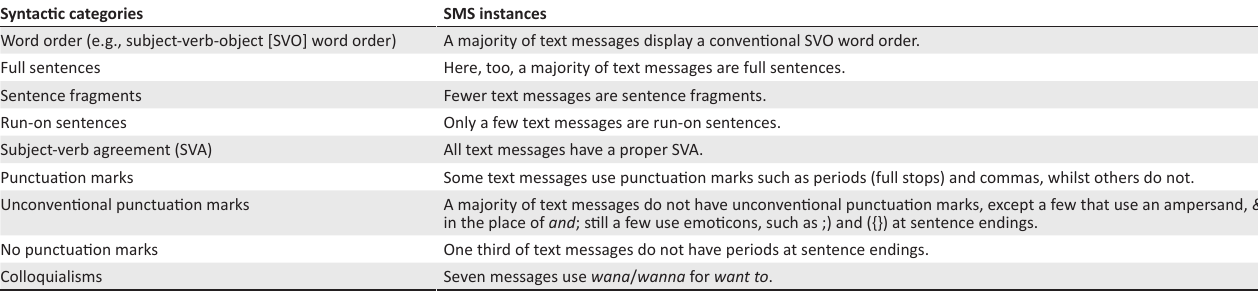
TABLE 3: Syntactic categories and instances of participants’ text messages that fit into these categories. Syntactic categories